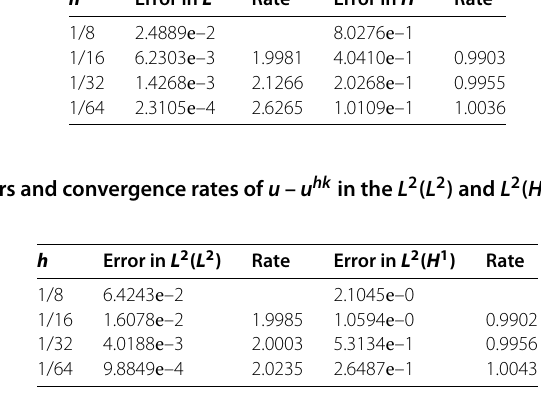
Table 2 The errors and convergence rates of v – v hk in the L 2 and H 1 norms concerning h at t = 1 h Error in L 2 Rate Error in H 1